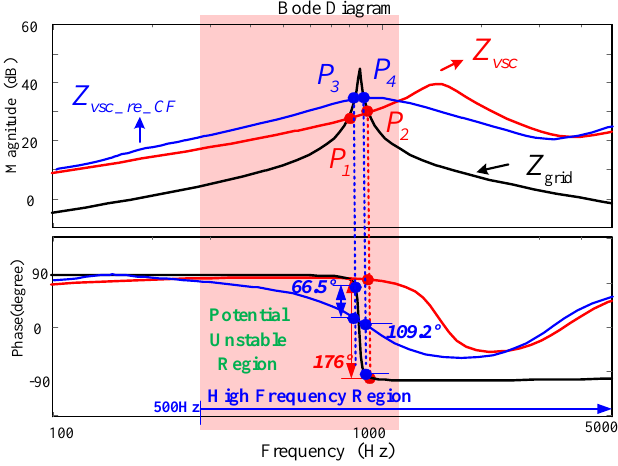
Figure 2. Bode diagram of VSC impedance and grid impedance.